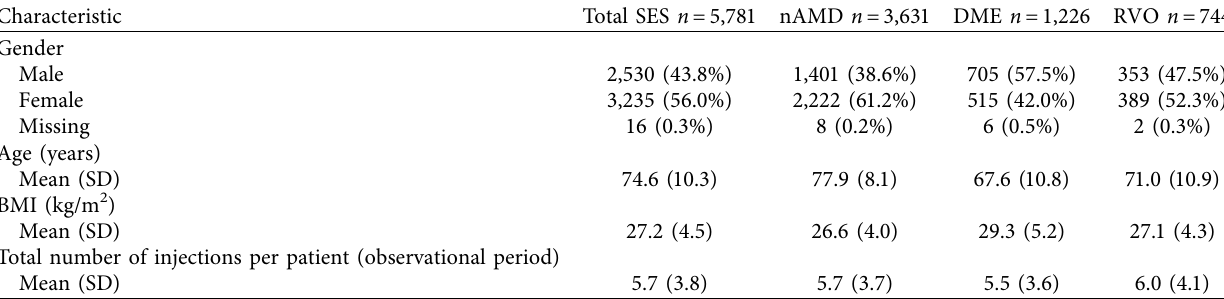
Table 1: Demographic characteristics of the study population.